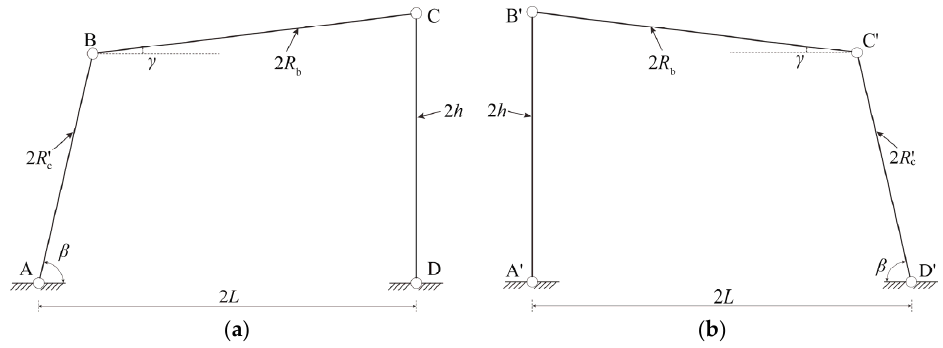
Figure 4. Planar four-bar linkage mechanism of PCRF: ( a ) θ 1 < 0; ( b ) θ 1 >